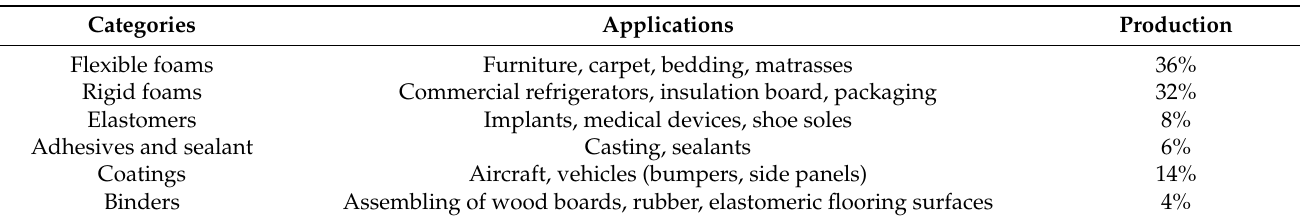
Table 1. Categories of PU